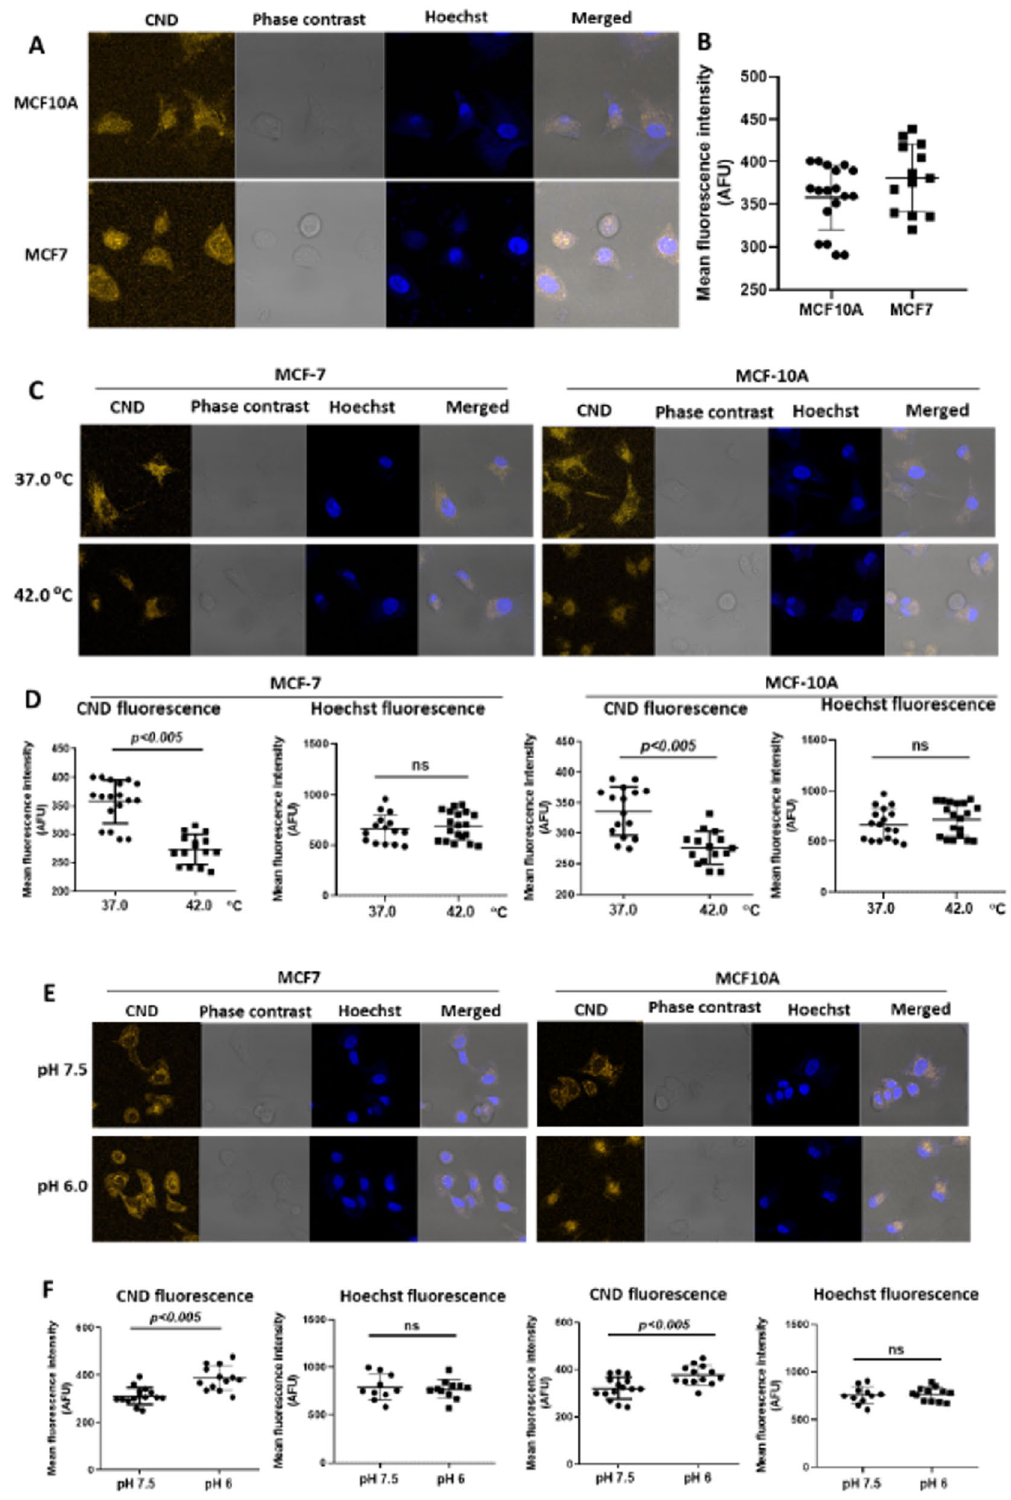
Figure 4. ( A , B ) Microscopic images (fluorescence and bright field) of MCF-7 and MCF-10 A cells, incubated with CND (5% vol./vol.) for 30 min. Quantification of fluorescence of cellular CND, in this experiment, is shown in ( B ). ( C , D ) Microscopic images (fluorescence and bright field) of MCF-7 and MCF-10 A cells, incubated with CND (5% vol./vol.) for 30 min and kept under different temperature (37 °C and 42 °C) for another 30 min. Quantification of fluorescence of cellular CND, in this experiment, is shown in ( D ). ( E , F ) Microscopic images (fluorescence and bright field) of MCF-7 and MCF10-A cells, incubated with CND (5% vol./vol.) for 30 min and kept under different pH (6.0–7.5) Quantification of fluorescence of cellular CND, in this experiment, is shown in ( F ). (AFU stands for arbitrary fluorescence